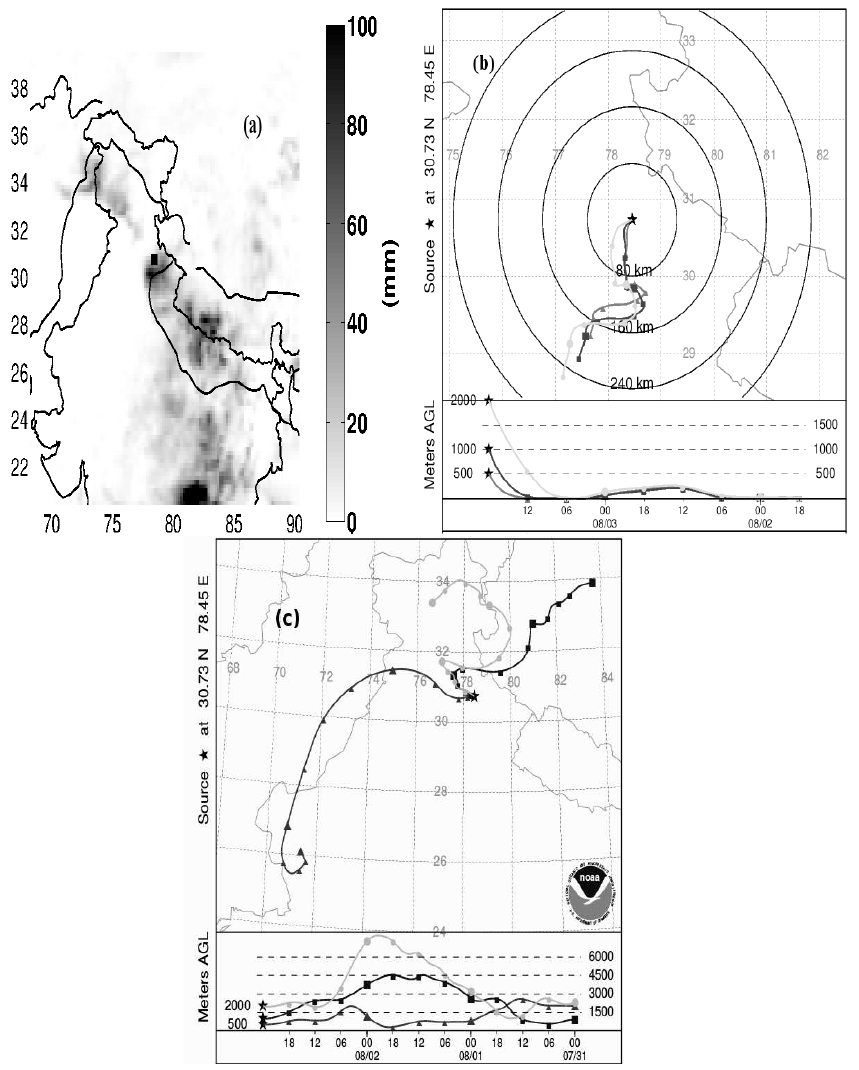
Figure 6. (a) TRMM 3B42v7 daily accumulated rainfall for 3 August 2012, (b) 48h back trajectories towards Uttarkashi ending 18:00UTC on 3 August 2012, and (c) 96h back trajectories towards Uttarkashi ending 00:00UTC on 3 August